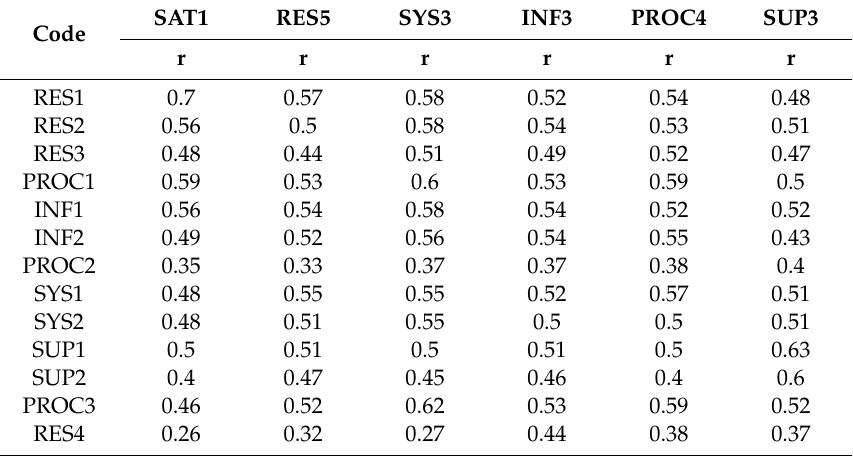
Table 7. Relationship of e-service quality dimensions with e-service attributes.